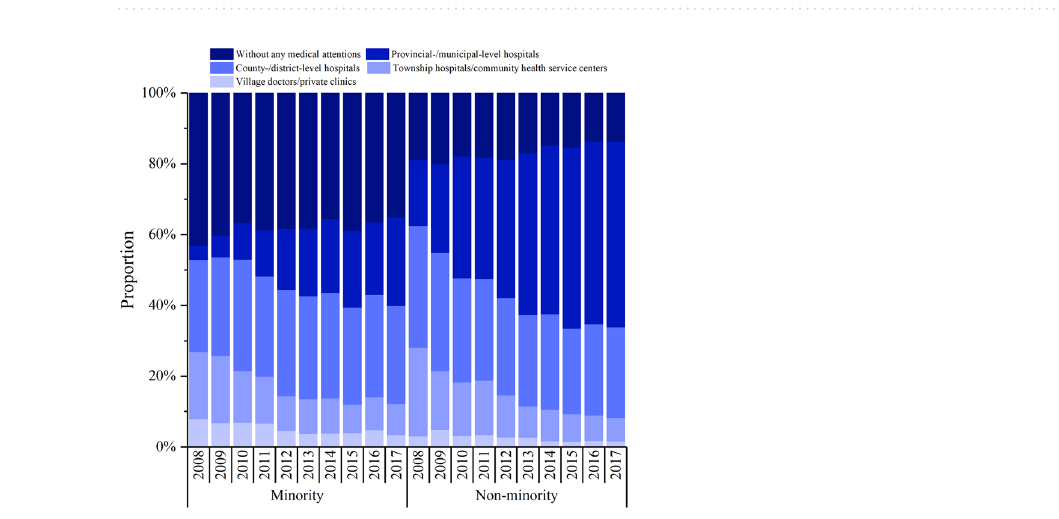
Figure 5. The top four causes of death of children under-five years old in Sichuan Province.